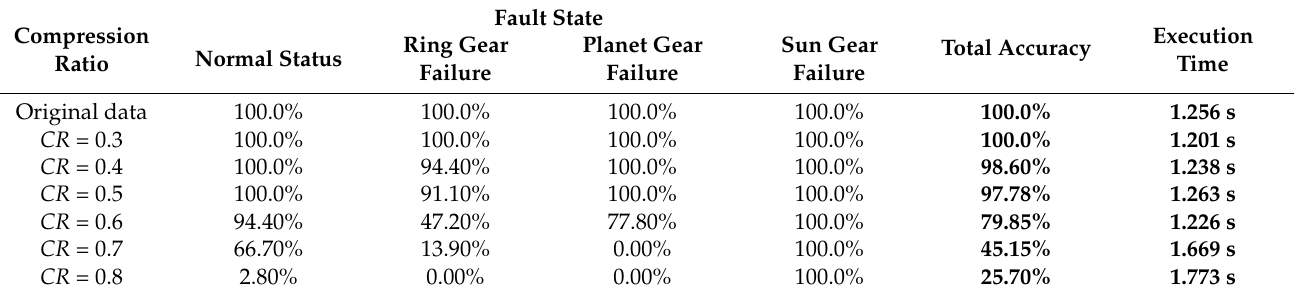
Table 5. Analysis of the results of the AlexNet diagnosis method under different compression